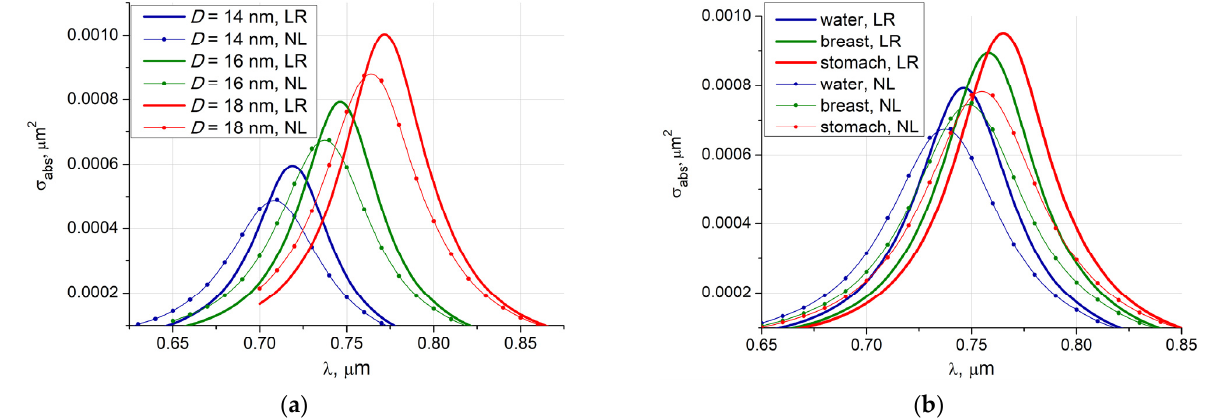
Figure 5. Absorption cross-section versus the exciting wavelength for spherical core-shell Fe 3 O 4 @Au particle with gold shell thickness d = 2 nm: ( a ) particle is deposited in water, results for different core diameters D and local (LR), non-local responses (NL) are presented; ( b ) particle with core diameter D = 16 nm is deposited in different ambient media: water n e = 1.33, breast n e = 1.405, stomach n e = 1.446.